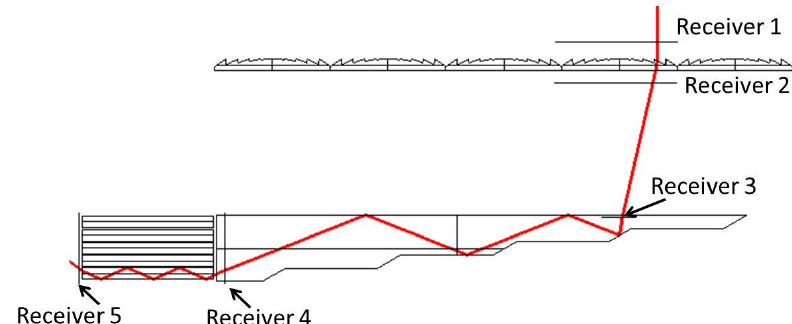
Figure 7. Illustration of the simulation structure for loss analysis and single ray-tracing analysis for design verification.